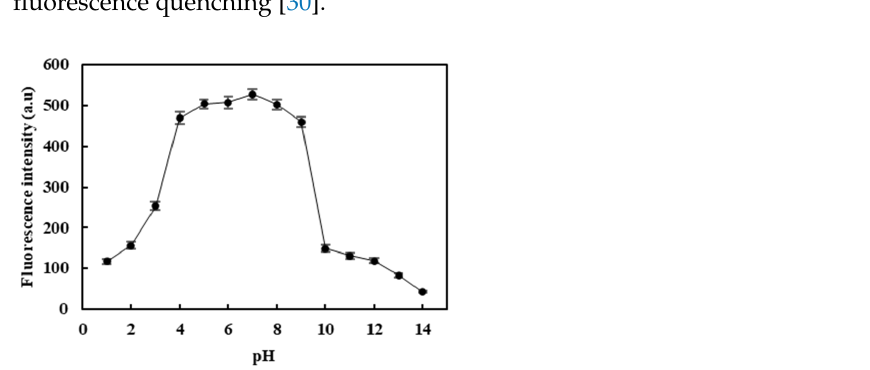
Figure 5. The fluorescence excitation spectrogram of CDs and fluorescence emission spectrogram of CDs and the CDs/Fe 3+ composite.